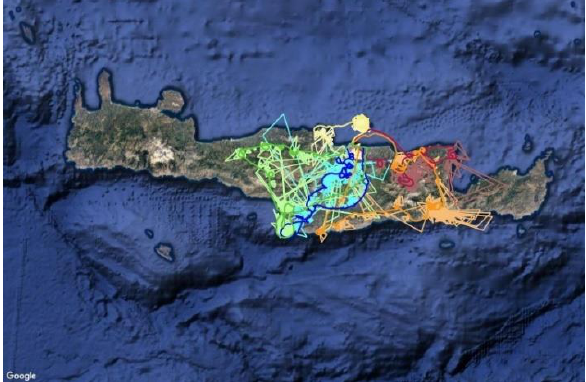
Figure 5: Footprints and flight's path (each in different colour) of the Aerial Archaeological Survey in Crete on the online platform (accessible at the address http://photogrammetry.ims.forth.gr/webgis/).